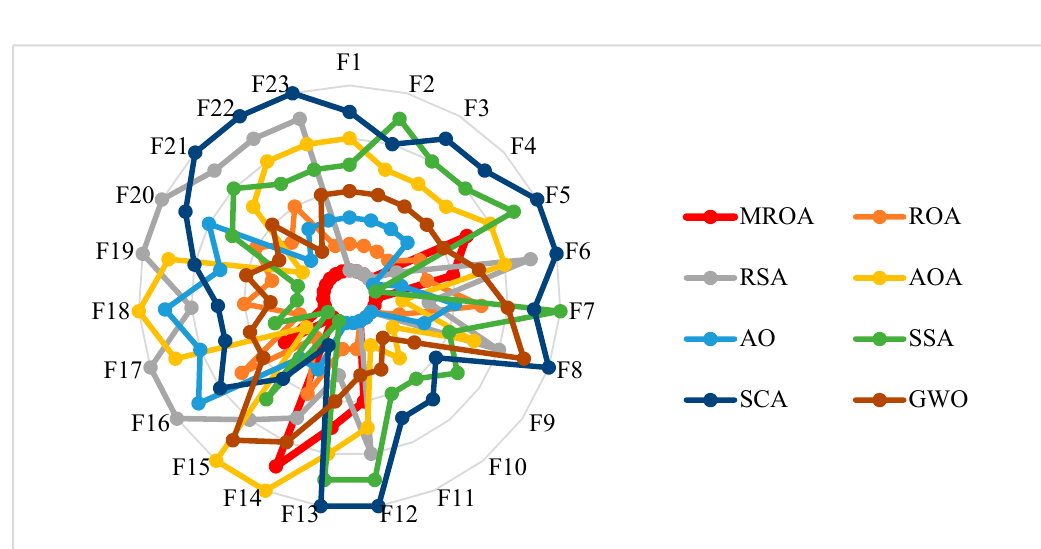
Figure 6. The radar graphs of algorithms on 23 benchmark functions.